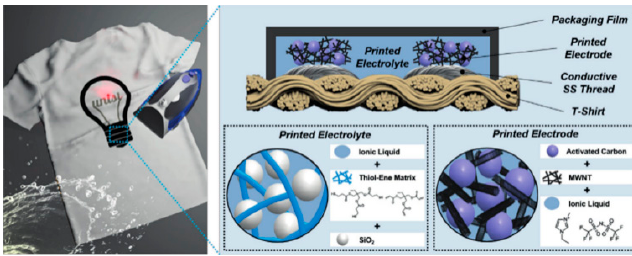
Figure 4. A schematic of screen printing activated carbon-based supercapacitors on clothes. Left : a supercapacitor printed on a T-shirt; Right : structure of a full-printed supercapacitor including electrodes and electrolytes. Reproduced from [54], with permission from Wiley, 2018.